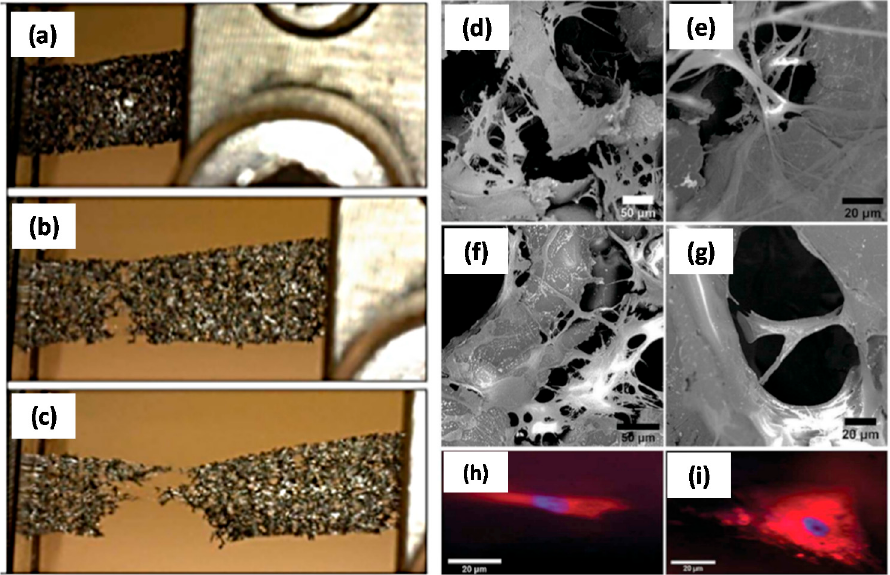
Figure 23. ( a ) GrF-PLC sample in tensile test setup; ( b ) GrF-PLC sample in tension showing signs of necking; ( c ) GrF-PLC after tensile failure, load prior to failure can be seen to be borne by a few high strength strands. ( d , e ) SEM images of graphene foam scaffold with human mesenchymal stem cells (hMSCs); ( f , g ) SEM images of graphene foam-PLC hybrid scaffold with human mesenchymal stem cells (hMSCs); ( h ) Fluorescence microscopy image of stem cells on graphene foam, cells appears severely stretched and thinned; ( i ) Fluorescence microscopy images of stem cells on graphene foam-PLC scaffold [82].